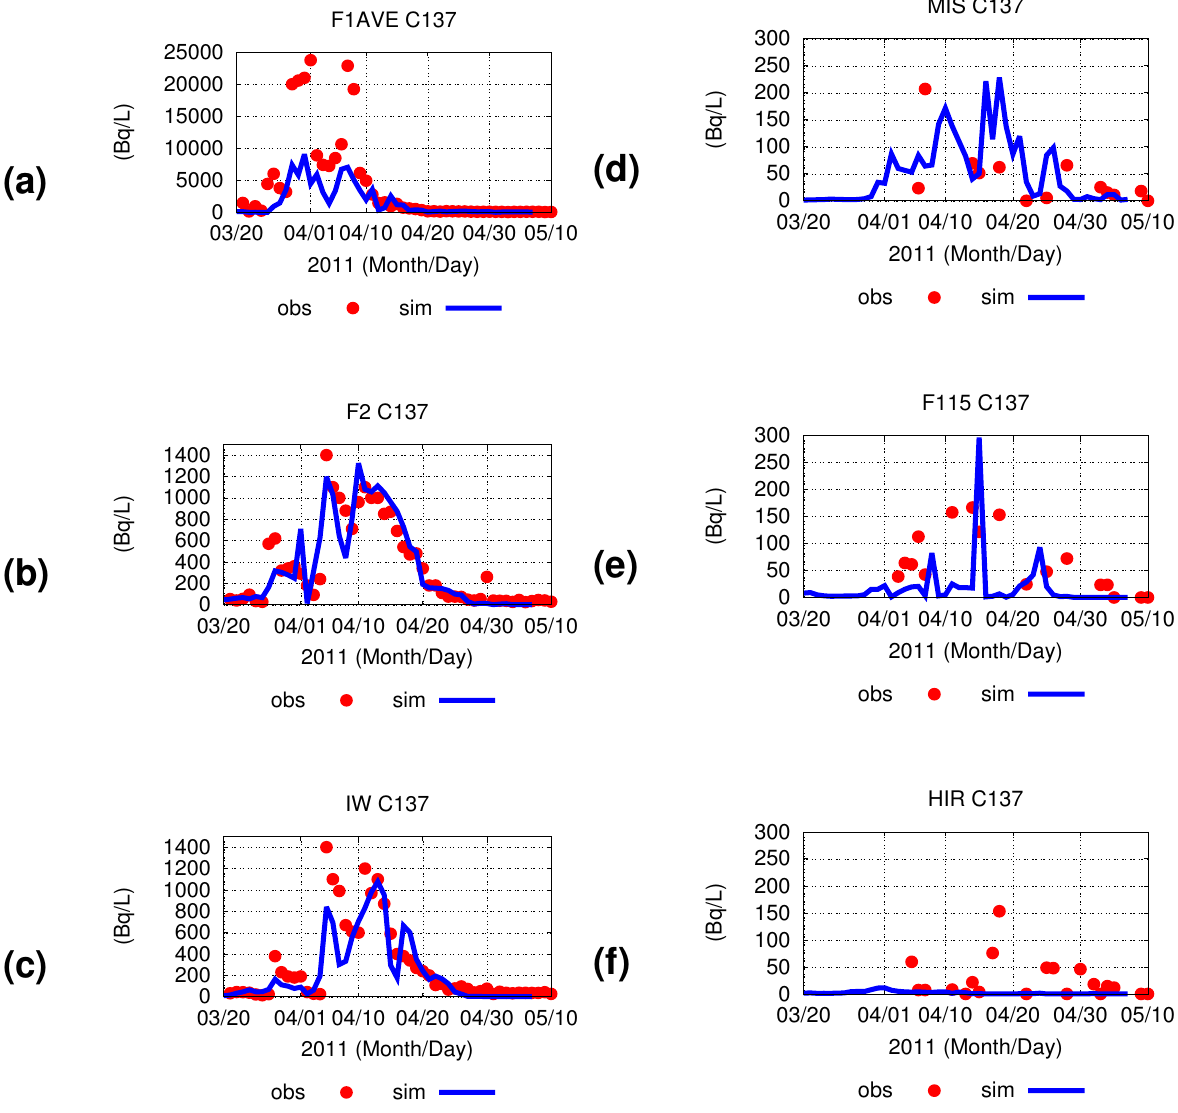
Fig. 10. Time sequences (curves) of 137 Cs at 1m depth on the points along the Fukushima coast simulated by the JCOPE-T-2-C-E case. Closed circles denote the observation at the corresponding points (see Fig. 12c for locations). (a) In front of FNPP. Closed circles denote the average of the measurements at two positions of the 5th–6th and south discharge canal waters. (b) In front of Fukushima Daini nuclear power plant (10km south of FNPP). (c) The Iwasawa Coast (16km south of FNPP). (d) 15km off Minamisoma. (e) 15km off FNPP. (f) 15km off Hirono.